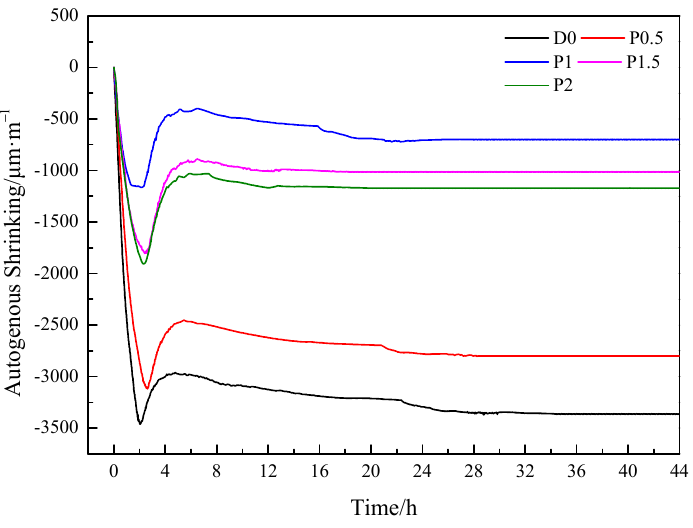
Figure 4. The autogenous shrinkage of mortar.